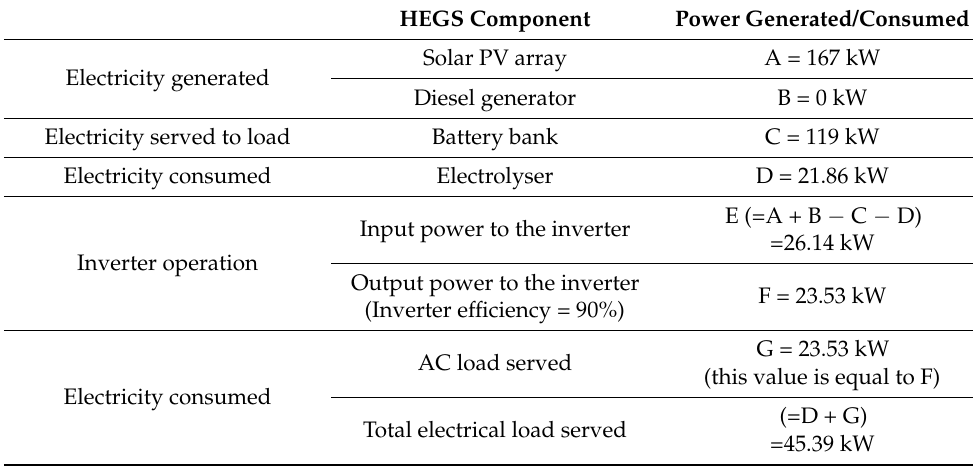
Table 8. Energy balance calculation from time series plot at 12th